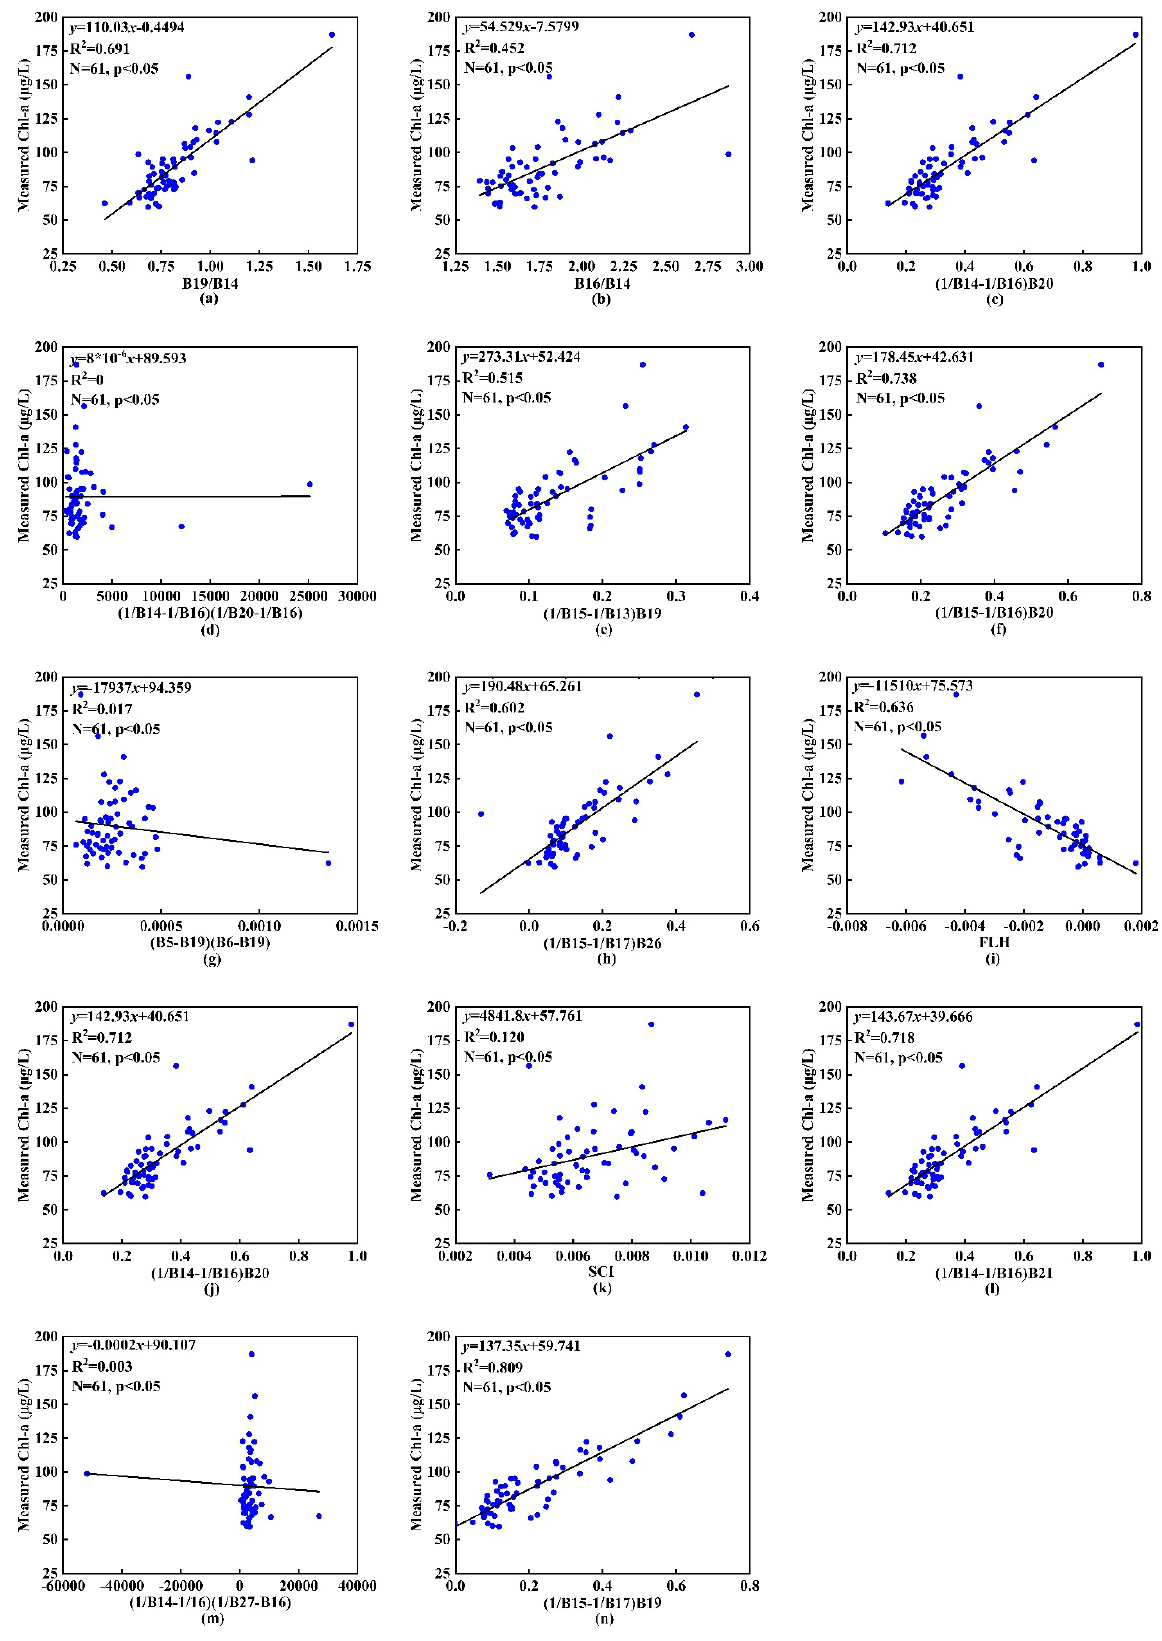
Figure A3. Comparison of existing Chl-a concentration retrieval algorithms based on OHS imagery. ( a – n ) are the models reconstructed by applying the algorithms in Table A3 to Dianchi Lake through calibration parameters.